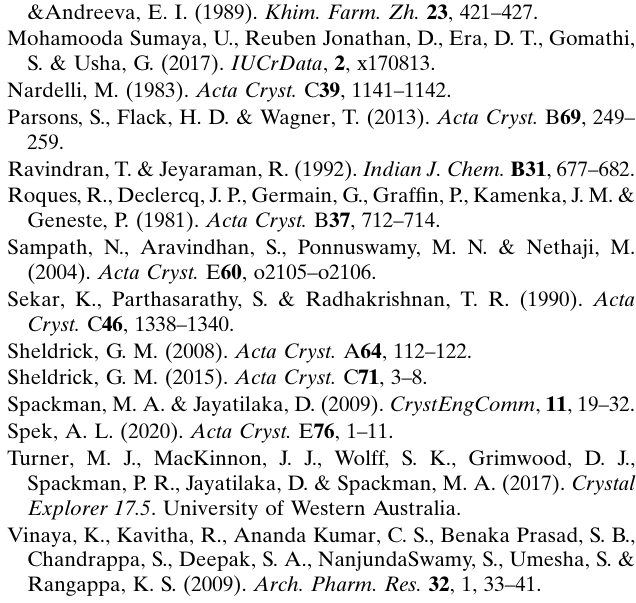
(C) for other H atoms. eq